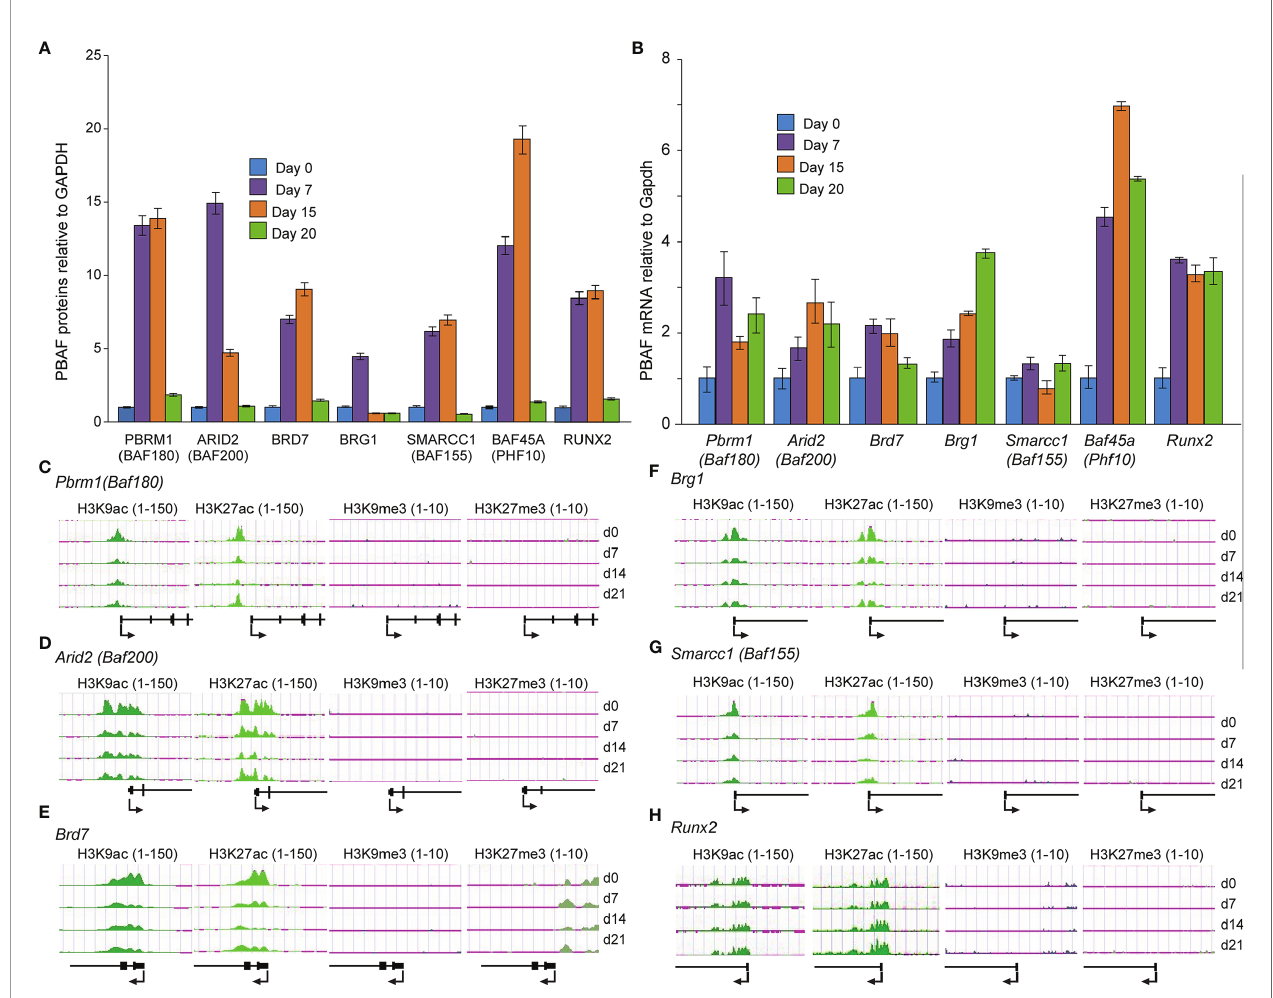
FIGURE 4 | PBAF complex is critical for early differentiation and matrix maturation. (A) Quantitative Western blot analysis of PBAF factors from primary rat calvarial osteoblast cells induced to differentiate for 20 days. (B) Relative mRNA levels of PBAF complex, obtained by real-time RT-qPCR using DNase I treated total RNA isolated from murine calvarial osteoblast cells induced to differentiate for 20 days. (C-H) Histone H3K9 and H3K27 modi fi cations on the promoter regions of PBAF complex members and Runx2 during Bone Marrow Stromal Cells (BMSCs) differentiation. Illumina ChIP-seq genomic tracks at (C) Pbrm1 (Baf180) , (D) Arid2 (Baf200) , (E) Brd7 , (F) Brg1 , (G) Smarcc1 (Baf155) and (H) Runx2 promoter regions. Quantitative peaks representing active chromatin marks H3K9ac and H3K27ac, as well as peaks representing repressive chromatin marks H3K9me3 and